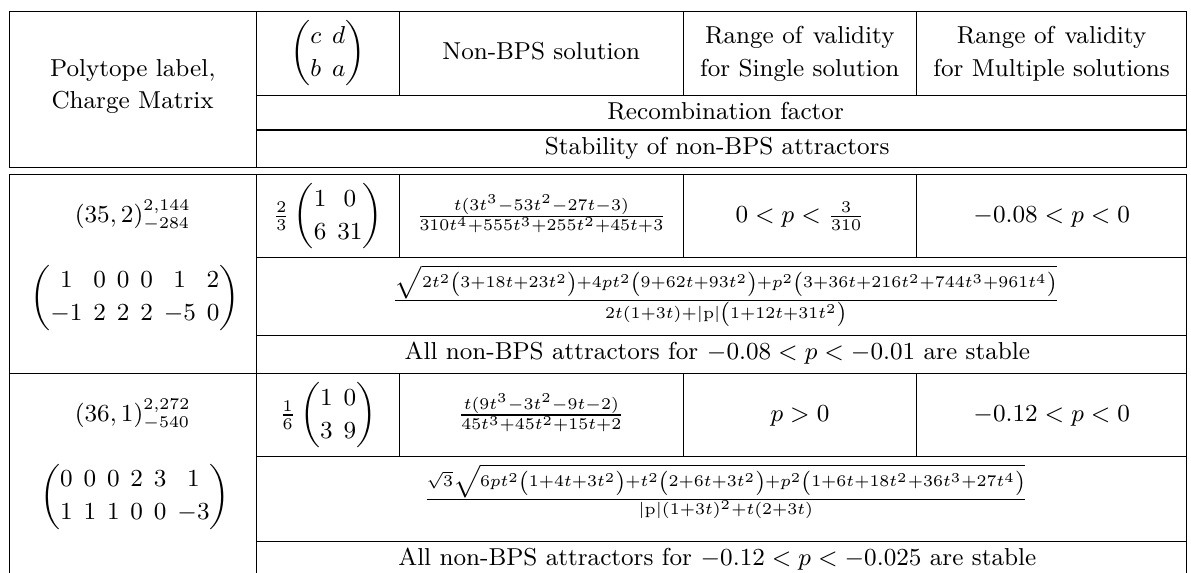
Table 19 . Non-BPS extremal (multiple) black strings in one-modulus THCY models,